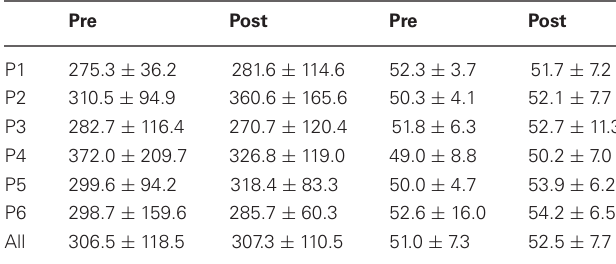
Table A1 | Mean ± Standard deviation of latency and of duration in milliseconds for both targets in the two periods, for every participant and the group of participants (All).